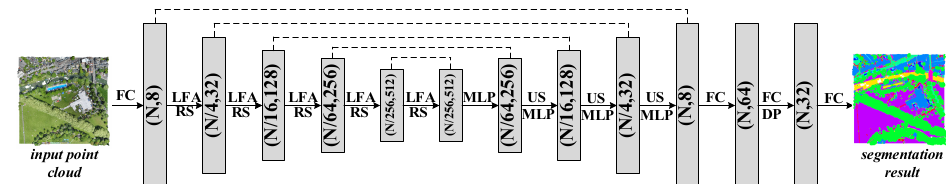
Figure 4. The structure of RandLA-Net. The numbers in the grey block show the number of channels of the feature and the number of points of the input, respectively. FC, LFA, RS, MLP, US, DP, and N represent the fully connected layer, local feature aggregation, random sampling, multi-layer perceptrons, up-sampling, dropout, and the number of input points (for example, N = 65,536), respectively.